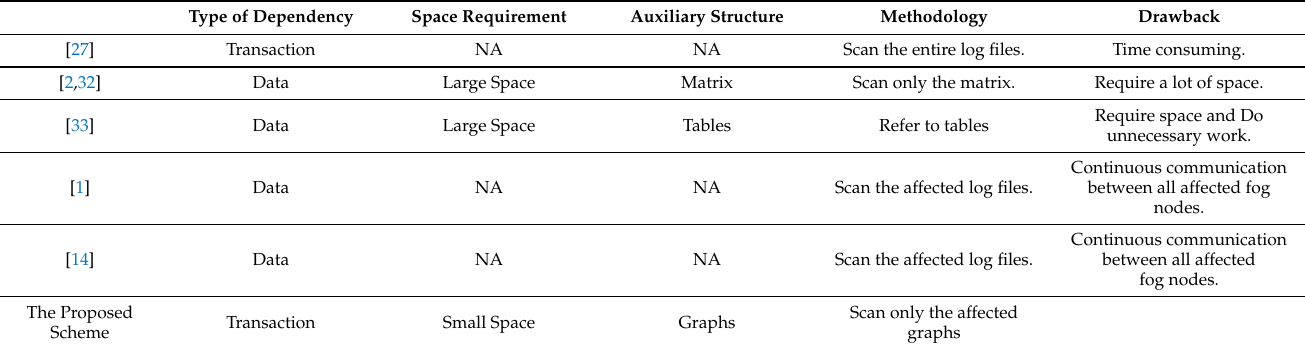
Table 1. A comparison table between our scheme and other existing